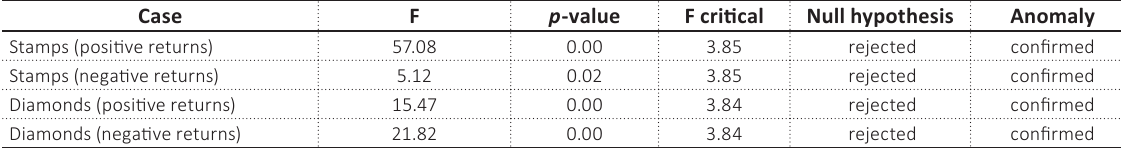
Table A3. ANOVA test